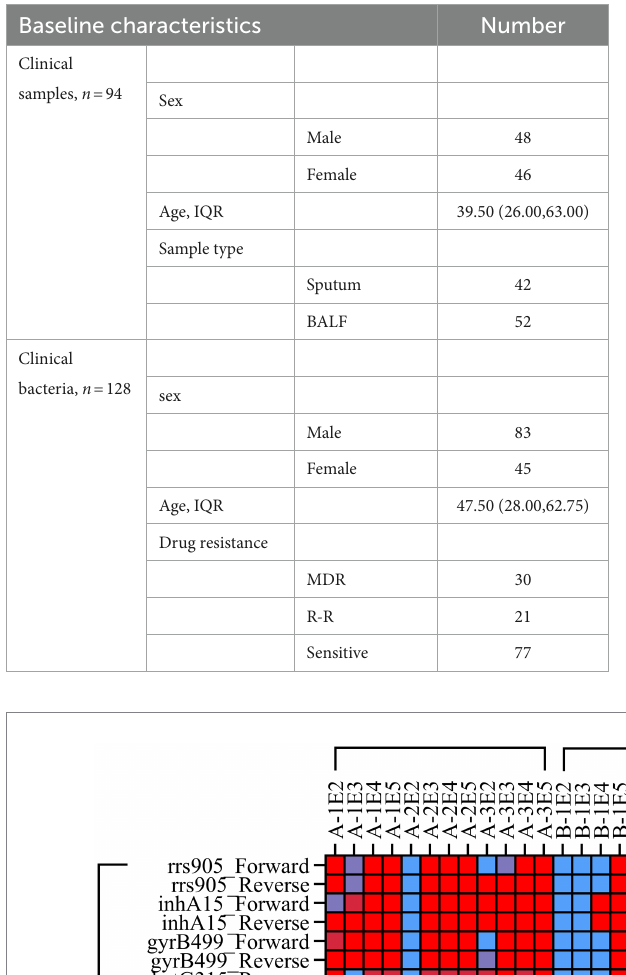
TABLE 2 Baseline characteristics of tuberculosis patients in clinically isolated samples.